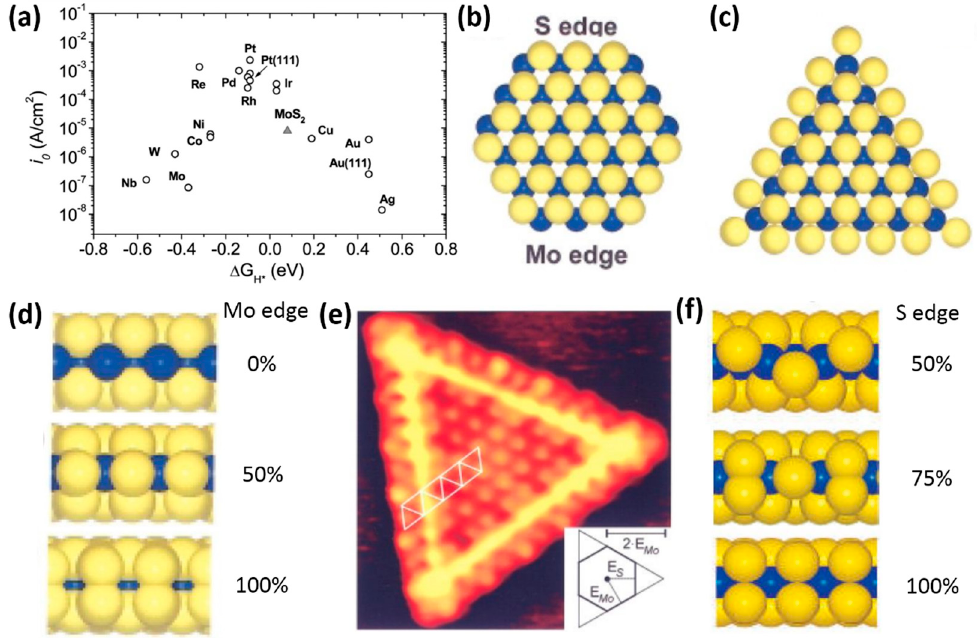
Figure 1. ( a ) “Volcano plot” of experimentally measured exchange current density as a function of the DFT-calculated Gibbs free energy of adsorbed atomic hydrogen for vary catalysts [25]; ( b ) Molecular model of a bulk truncated MoS 2 hexagon with Mo and S edges being exposed [33]; ( c ) Triangular shape of MoS 2 exposing Mo edges (Mo atoms terminate with S dimers) [33]; ( d ) Side view of Mo edges with 0%, 50% and 100% coverage, respectively [33]; ( e ) An atom-resolved STM images of MoS 2 clusters [33]; ( f ) (1010) S edge with varying sulfur coverage [34]. Reproduced from [25] with permission from copyright 2007 American Association for the Advancement of Science, [33] with